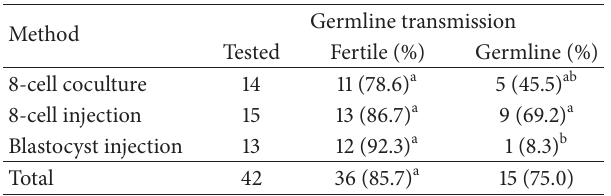
Table 4: Germline-transmitting chimeras produced from